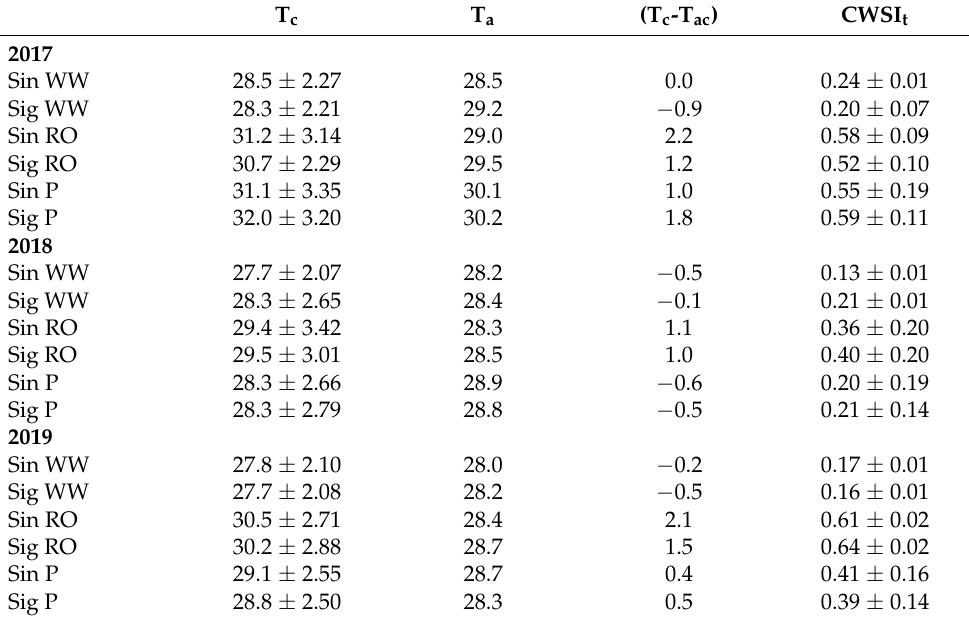
Table 2. Seasonal mean canopy temperature (T c ), air temperatures 1.5 m above the canopy (T ac ), canopy- air temperature difference (T c -T ac ) and theoretical crop water stress index, CWSI t in the growing seasons of 2017–2019. Abbreviations were as follows: WW—unlimited water, RO—water stress conditions, P—rainfed, Sinara—Sin,